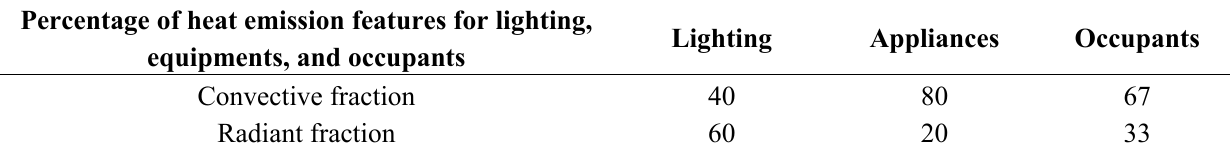
Table 7. Percentage of heat emission features for lighting, equipments, and occupants. Percentage of heat emission features for lighting,